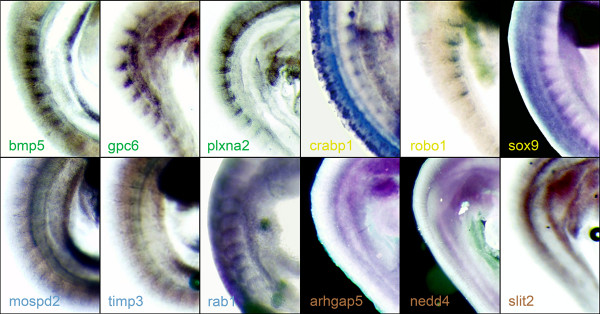
Whole-mount in situ hybridization of candidate genes differentially-expressed between A- and P-half-sclerotome. 56 candidate genes were tested for differential expression in A- and P-sclerotome-halves by whole-mount in situ hybridization. The resultant expression patterns were placed into four different groups based upon their certainty of differential expression. Groups 1–3 represent genes with decreasing certainty of differential expression (group 1, high certainty; group 3, low certainty), while group 4 genes show no apparent staining or no observed differential expression. Three examples from each group are shown: Group 1: bmp5, gpc6, plxna2 (green text); Group 2: crabp1, robo1, sox9 (yellow text); Group 3: mospd2, timp3, rab1 (blue text); Group 4: arhgap5, nedd4, slit2 (brown text). Table 1 and Additional File 8 present additional data for the remaining 44 genes.